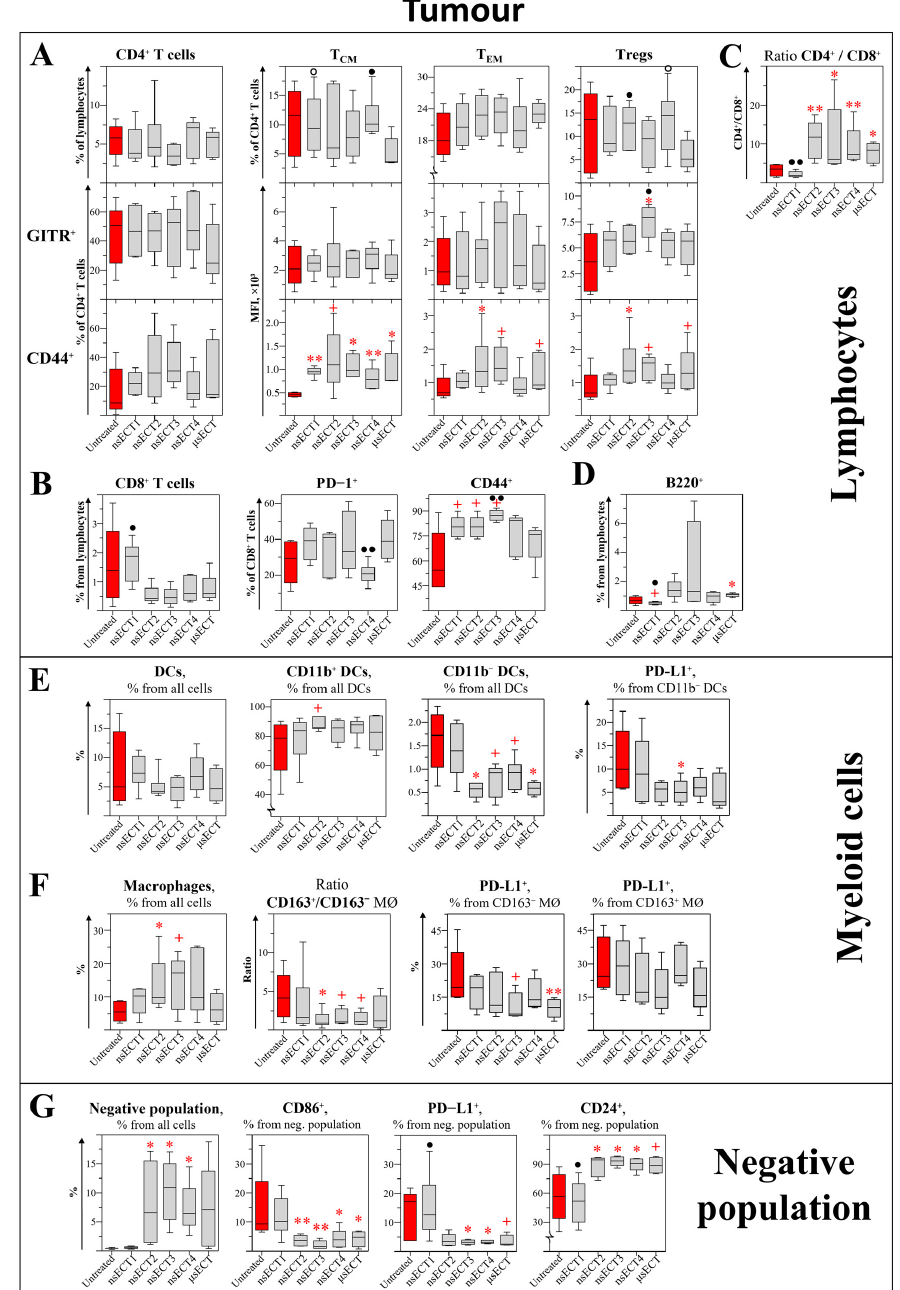
Figure 5. Time-dependent study. Lymphocyte ( A – D ), myeloid cells ( E , F ) and “Negative” (Lin − ) population ( G ) in mice tumours. Cytometry was performed with BD FACSAria III cytometer. Statistically significant (* p < 0.05; ** p < 0.005) differences and tendencies (+ p = 0.05–0.1) compared to the untreated group. Significant differences ( ● p < 0.05; ●● p < 0.005) and tendencies ( 🇴 p = 0.05– 0.1) compared to the μ sECT group.